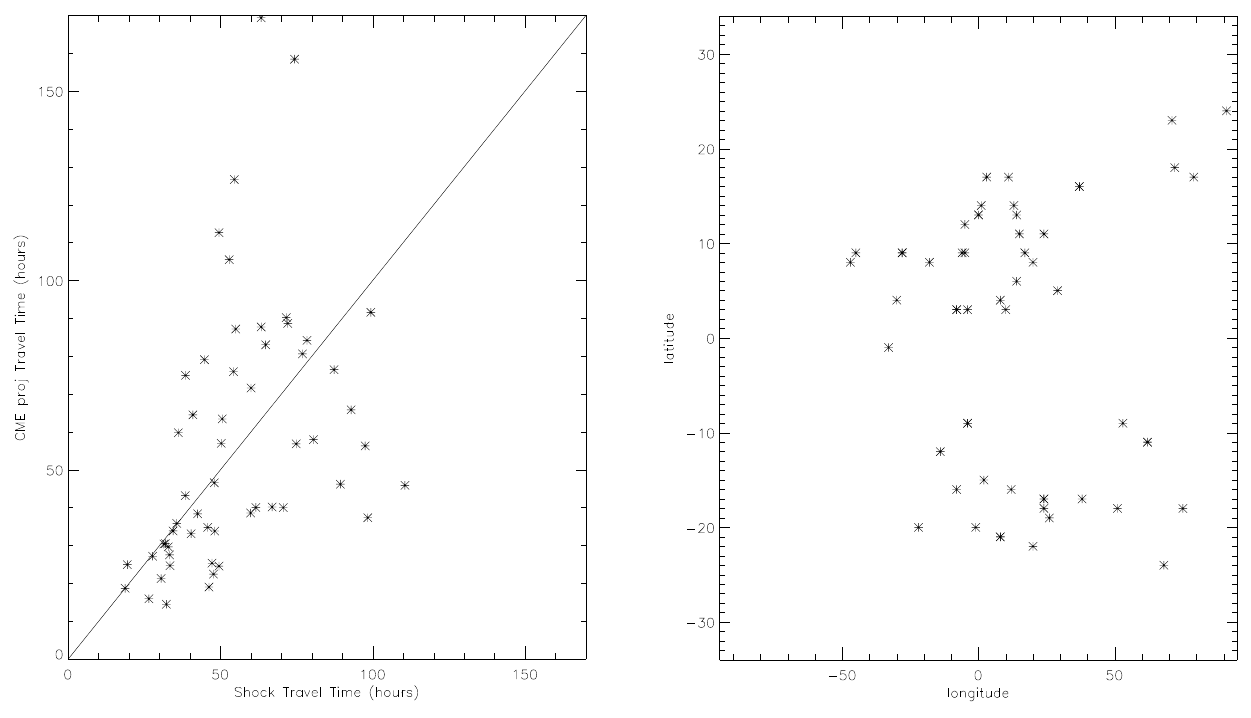
Fig. 2. Travel time calculated using the projected speeds versus real travel time.